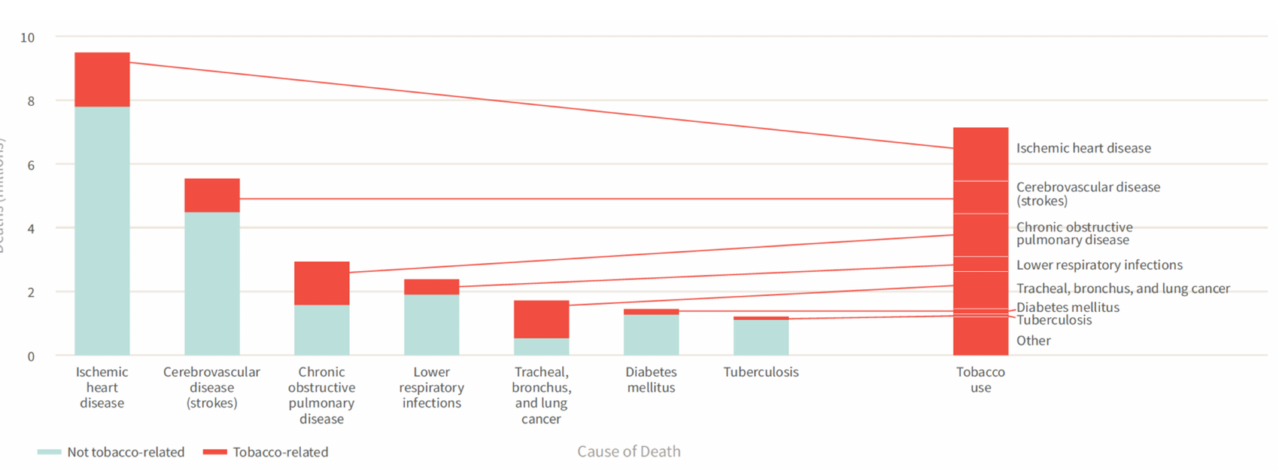
Figure 1. Tobacco use contributes to the leading causes of global deaths including non-communicable diseases as well as infectious diseases. Reused from The Tobacco Atlas, 6th edition with permission. Copyright ©2018 The American Cancer Society, Inc.